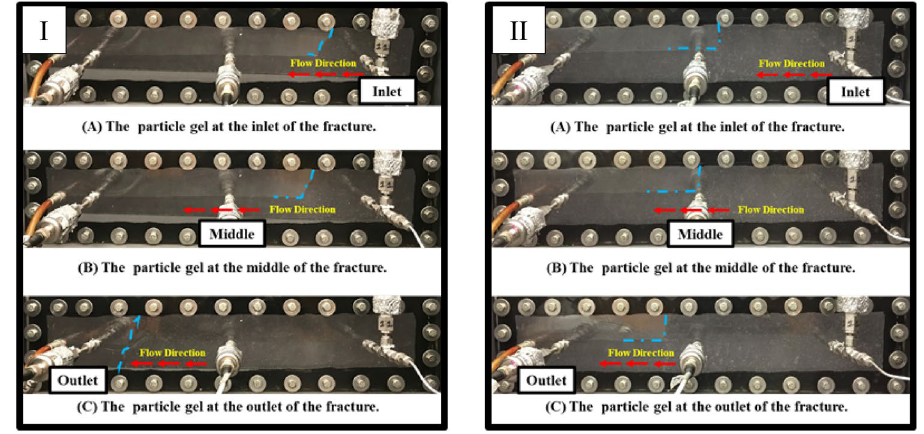
Fig. 3 Gel propagation through fractures: (I) gel particle size to fracture width ratio is 9.76 and (II) particle size to fracture width ratio is